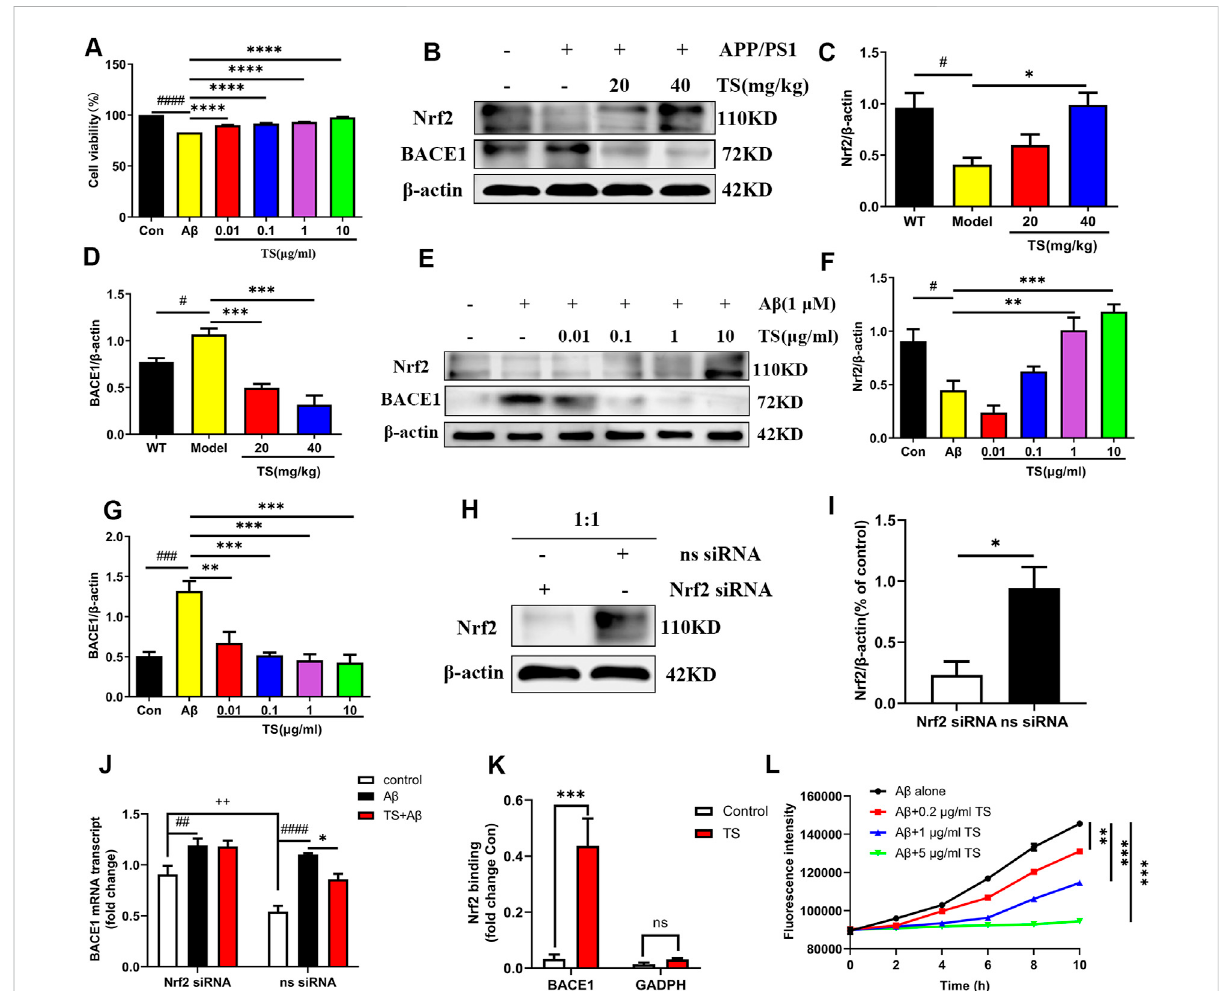
FIGURE 4 TS treatment promoted Nrf2 to inhibit the expression of BACE1 in the brain of APP/PS1 mice. (A) The effect of TS on the survival rate of A β - inducedPC12cellsfor24 hwasevaluatedbyMTTassay( #### p < 0.0001,**** p < 0.0001). (B) TheeffectofTSonNrf2andBACE1proteinsinthebrain of APP/PS1 mice were detected by Western blot. (C) Quantitative analysis of the relative expression level of Nrf2 protein in each group ( # p = 0.0195, * p =0.0151). (D) QuantitativeanalysisoftherelativeexpressionlevelofBACE1proteinineachgroup( # p =0.0343,*** p =0.0008,*** p =0.001). (E) The effect of TS on Nrf2 and BACE1 protein in A β -induced PC12 cells were detected by Western blot. (F) Quantitative analysis of the relative expression concertation of Nrf2 protein ineach group ( # p =0.0119, ** p = 0.0027, *** p = 0.0003). (G) Quantitative analysis ofthe relative expression concertation of BACE1 protein in each group ( ### p = 0.0003, ** p = 0.0016, *** p = 0.0003, *** p = 0.0002, *** p = 0.0001). (H) PC12 cells were transfected with Nrf2-siRNA and transfection reagent at 1:1 for 36h, and the expression of Nrf2 was detected by Western blotting. (I)